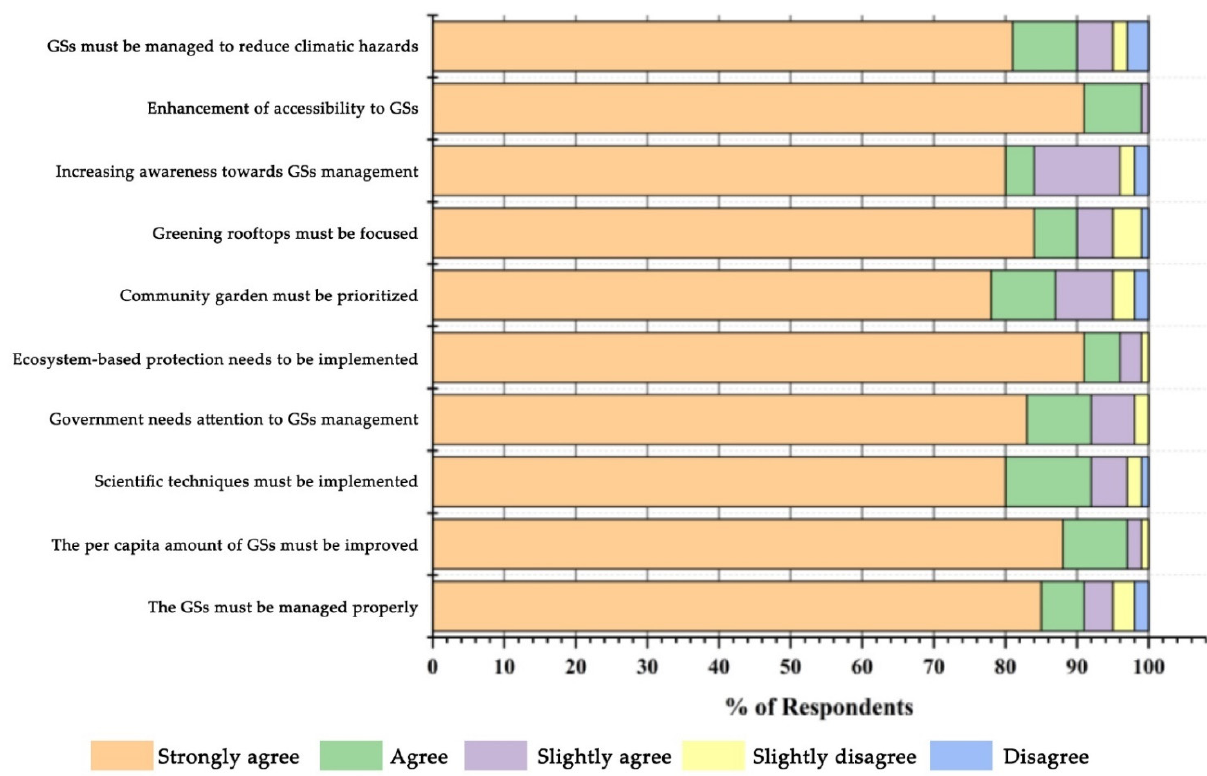
Figure 7. Level of agreement on attributes related to climate change adaptation.